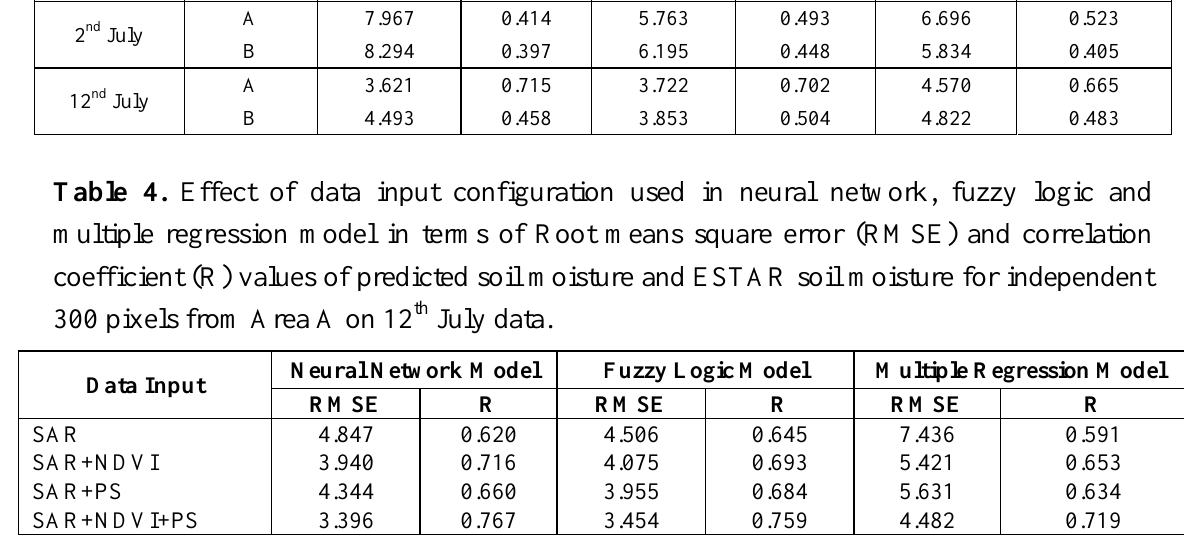
y = 0.016x + 0.252 R² = 0.240